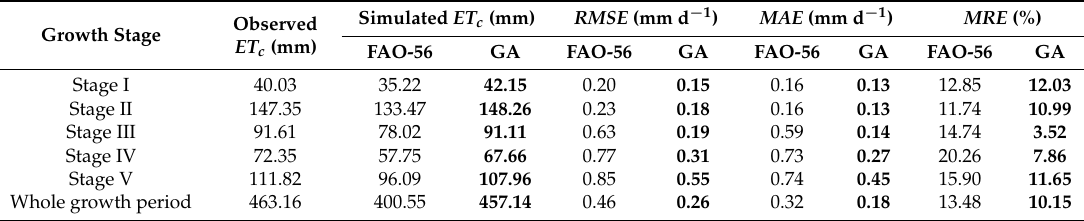
Table 6. Simulated wheat evapotranspiration ( ET c ) under full irrigation using the crop coefficients optimized by the genetic algorithm (GA) and recommended by the FAO-56, and the